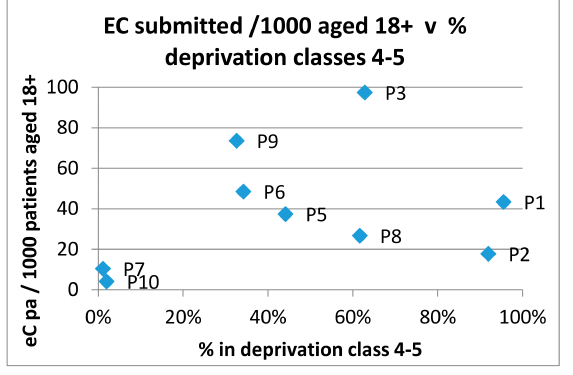
Figure 9. eConsult submission rates versus percentage of patients in the most affluent